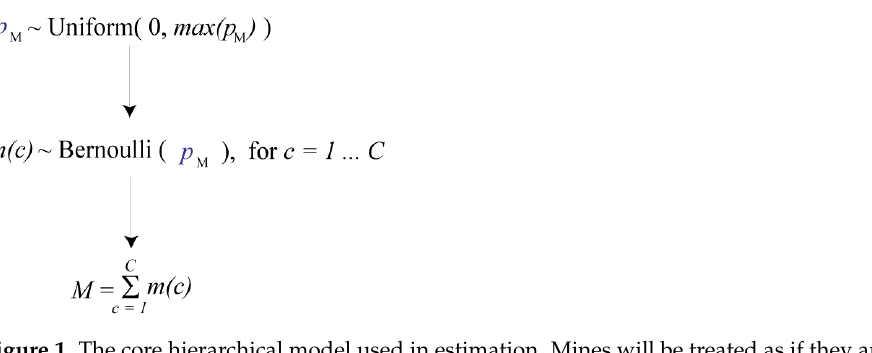
Figure 1. The core hierarchical model used in estimation. Mines will be treated as if they arose from this model.